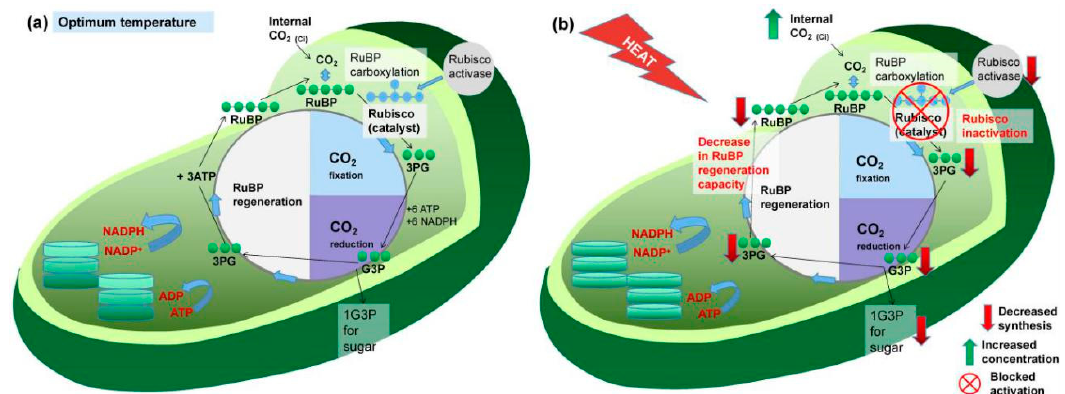
Figure 2. ( a ) Chloroplast function under optimum temperature; ( b ) disturbances of major biochemical processes of chloroplasts in grapevine leaves under heat stress. The activity of Rubisco activase is extremely heat-sensitive, and its inhibition blocks the activation of Rubisco and downstream reactions.